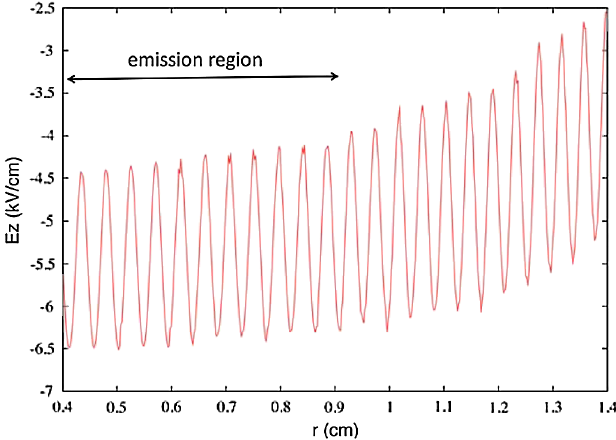
FIG. 16. Electric field at the cathode used for PARMELA simu- lations. The total electric field across the cathode surface is plotted versus radial distance from the symmetry axis. At a þ given point on the cathode, the field takes the form E z ¼ E z; DC E ! t Þ þ E ! t Þ , where E = cm , z; 1 sin ð z; 3 sin ð 3 z; DC (cid:2) 11 kV rf rf E : 4 kV = cm , and E = cm . The field is illus- z; 1 (cid:2) (cid:3) 9 z; 3 (cid:2) 9 kV trated for t ¼ (cid:1)= 2 ! at the peak of emission. Emission occurs rf only at those radii within the indicated